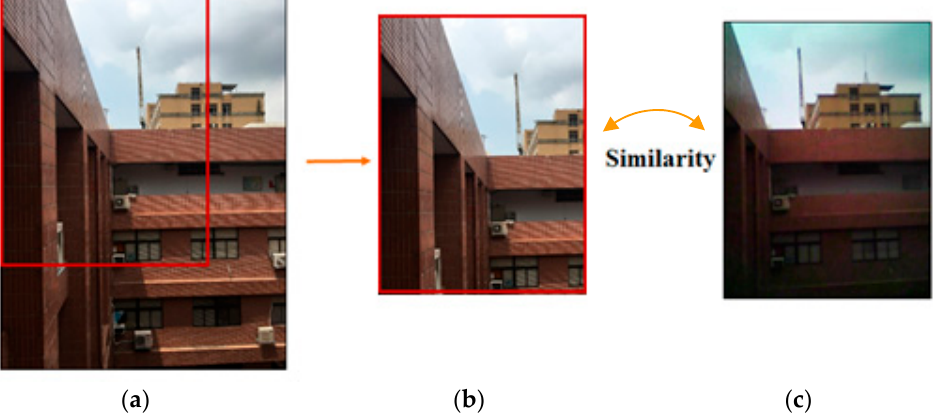
Figure 4. Illustration of image registration using NCC: ( a ) original image of iPhone SE. Down-sampling visible iPhone SE image. Spatial resolution: 4032 × 3204 × k %; ( b ) template image. Spatial resolution: 320 × 240; ( c ) registered image. Visible FLIR ONE image. Spatial resolution: 320 × 240.